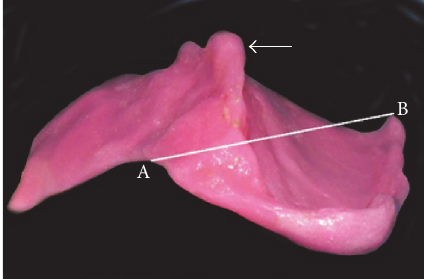
Figure 5: Palatal obturator. Note that arrow indicates extension of the resin in undercut areas seen along the defect margins. Line joining A and B indicates maximum stretchable distance of